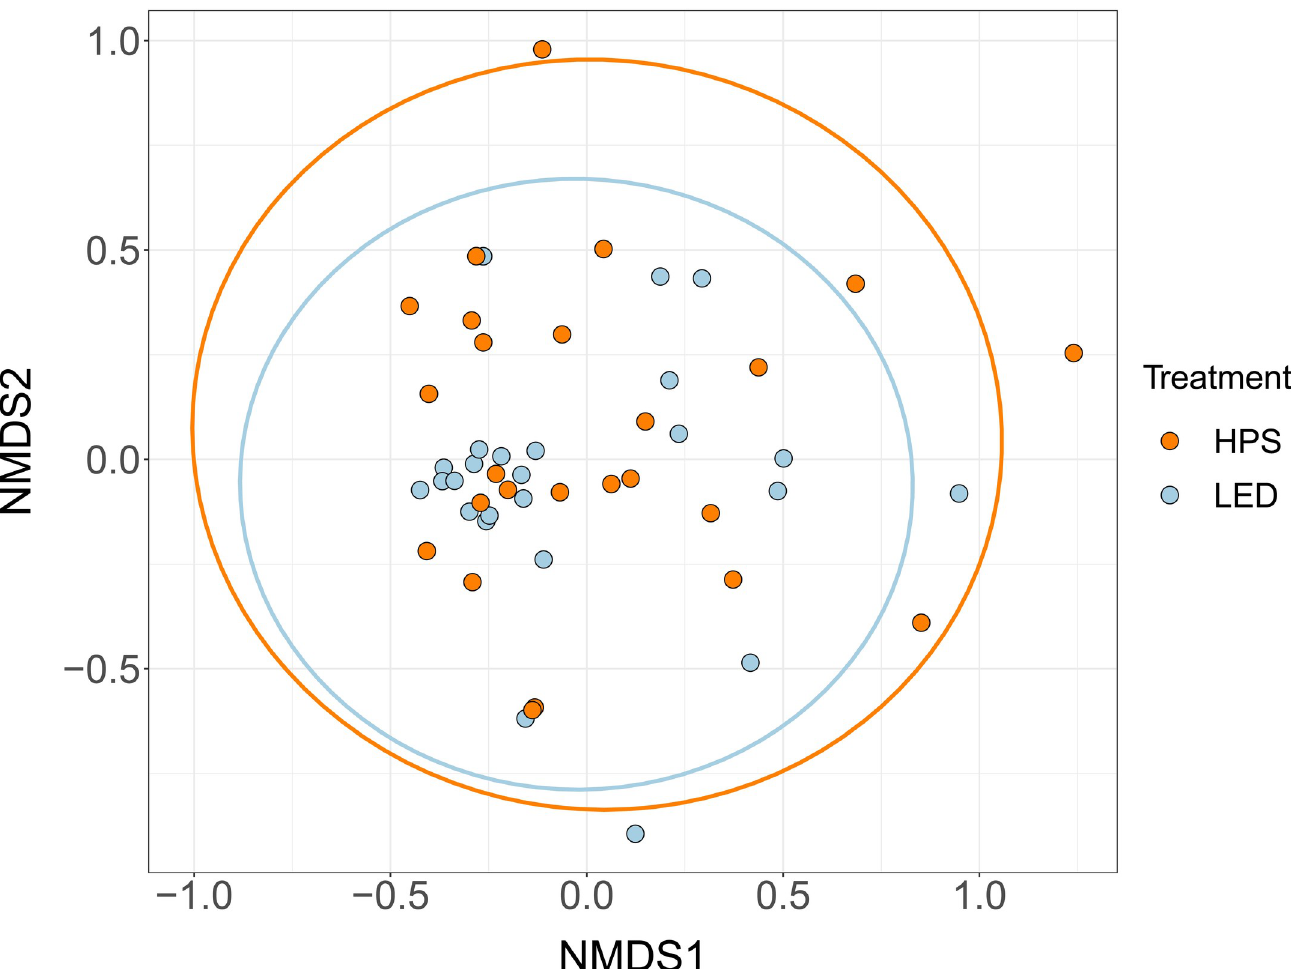
Fig 3. NMDS plot generated from Bray-Curtis dissimilarities. The nearly complete overlap between 95% confidence ellipses (solid lines) for both light treatments suggests similar species compositions.